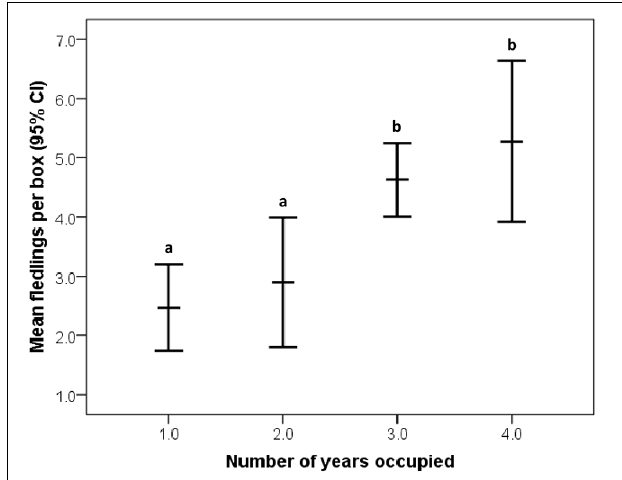
FIGURE 2 | Relationship between historical occupancy and reproductive success (annual number of fledglings per territory) in eastern bluebirds (95% CI for the mean). Significant ( P < 0 . 05) post-hoc differences are designated by letters (a,b).